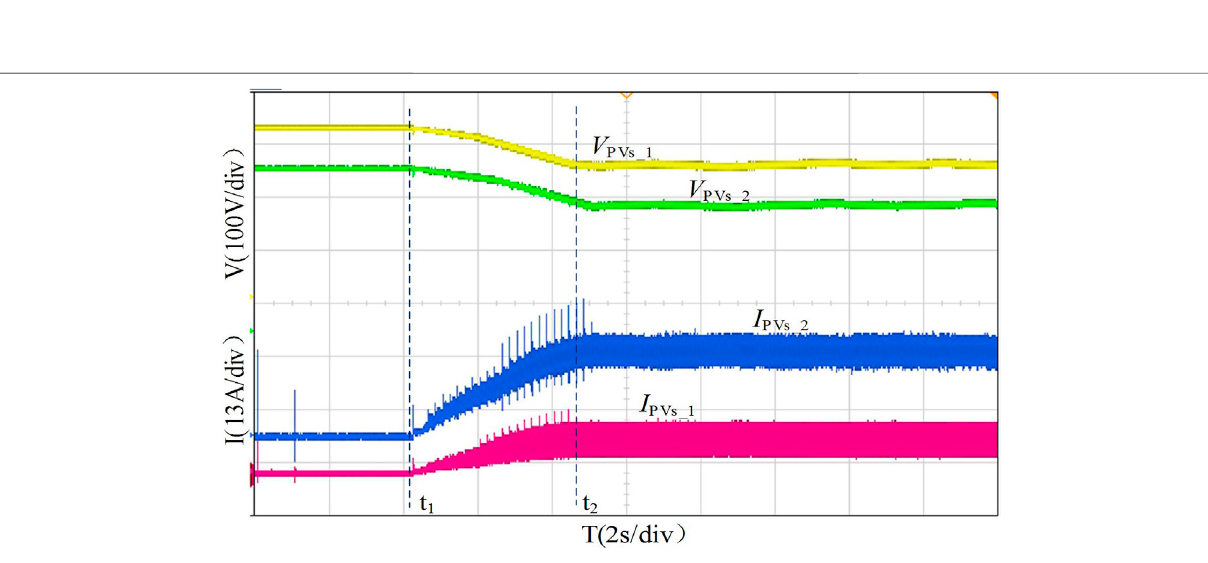
FIGURE 13 | Identi fi cation control test waveforms at the initial power-on